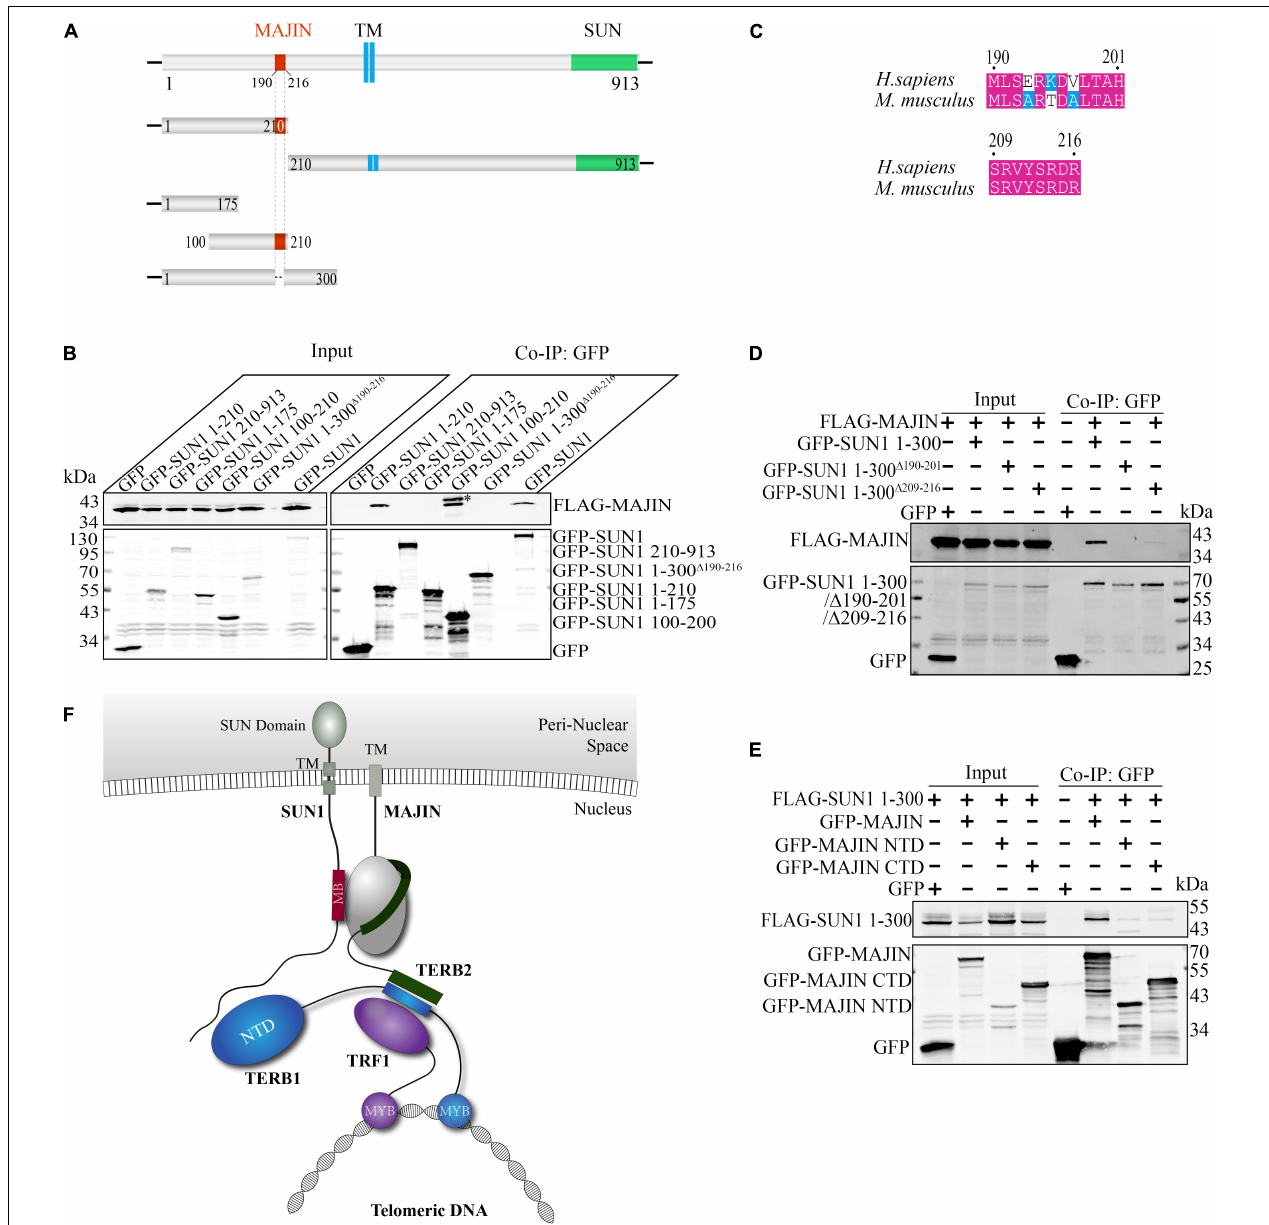
FIGURE 2 | Binding sites between SUN1 and MAJIN. (A) Illustration of the MAJIN-binding site at SUN1. The MAJIN-binding site is shown in red, the trans-membrane region is blue, and the SUN domain is green. TM: trans-membrane region. (B) The 190–216 Aa of SUN1 is the binding site of MAJIN. ∗ Indicating the band of GFP-SUN1 100–210 Aa. (C) Illustration of the two conserved sequences of SUN1 in the MAJIN binding site. (D) The SUN1-MAJIN interaction is affected by deletion of 190–201 and 209–216 Aa. (E) Both the NTD and CTD of MAJIN interact with SUN1. (F) Illustration of the interaction of SUN1 with MAJIN. The MAJIN-binding site is shown in red and named